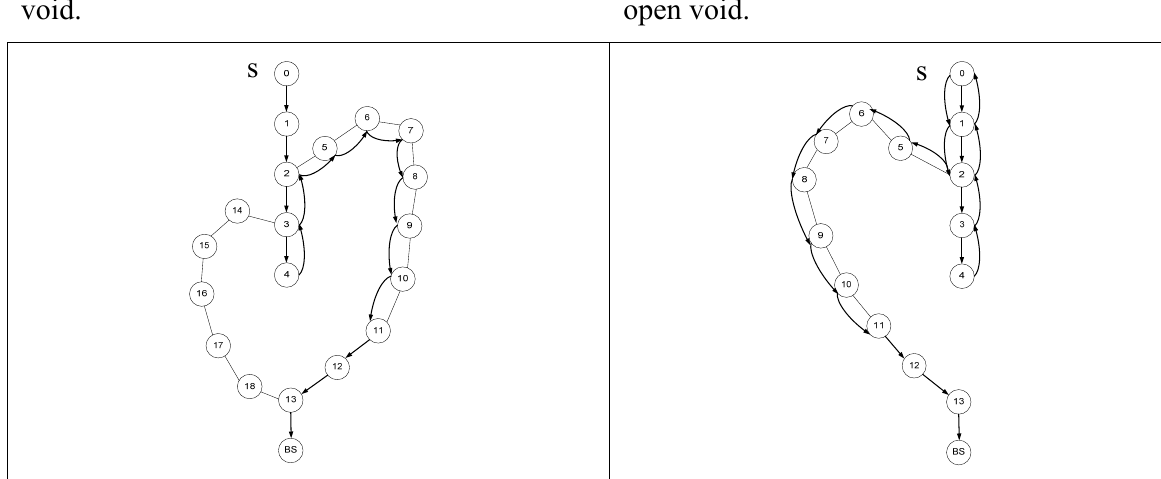
Figure 3. Perimeter mode in GPSR in a closed Figure 4. Perimeter mode in GPSR in an open